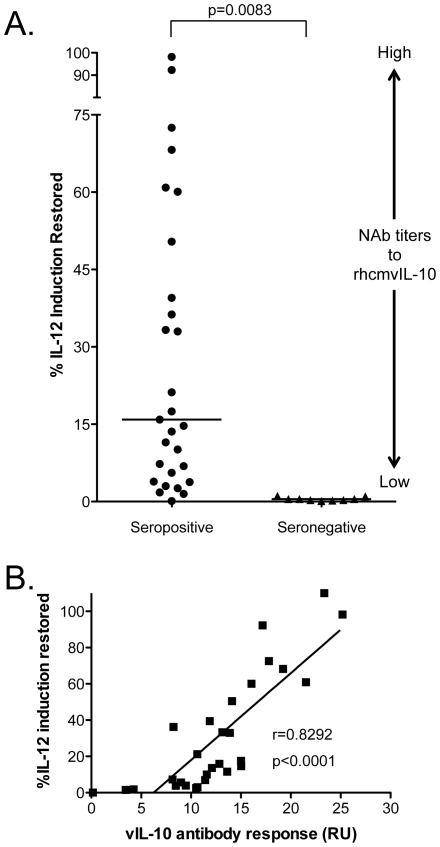
rhcmvIL-10 antibodies neutralized rhcmvIL-10 activity in stimulated PBMC.rhcmvIL-10 neutralization was determined by incubating LPS-stimulated PBMC with either rhcmvIL-10 and RhCMV seropositive plasma, or rhcmvIL-10 only. The % difference of PBMC IL-12 secretions in the rhcmvIL-10/ plasma versus plasma only (measured by ELISA) was termed “% IL-12 induction restored”. (A) Seropositive plasma sample neutralization of rhcmvIL-10 resulted in a range of 0–100% IL-12 induction restored with a significant difference between the RhCMV seropositive and seronegative samples (p = 0.0083; two-tailed student's t-test). The relative relation between %IL-12 restored and strength of NAB is shown on the right. (B) % IL-12 induction restored was found to be directly correlated to rhcmvIL-10 antibody titers (measured in RU) in rhesus macaque seropositive plasma (Pearson r = 0.8292. p<0.0001).